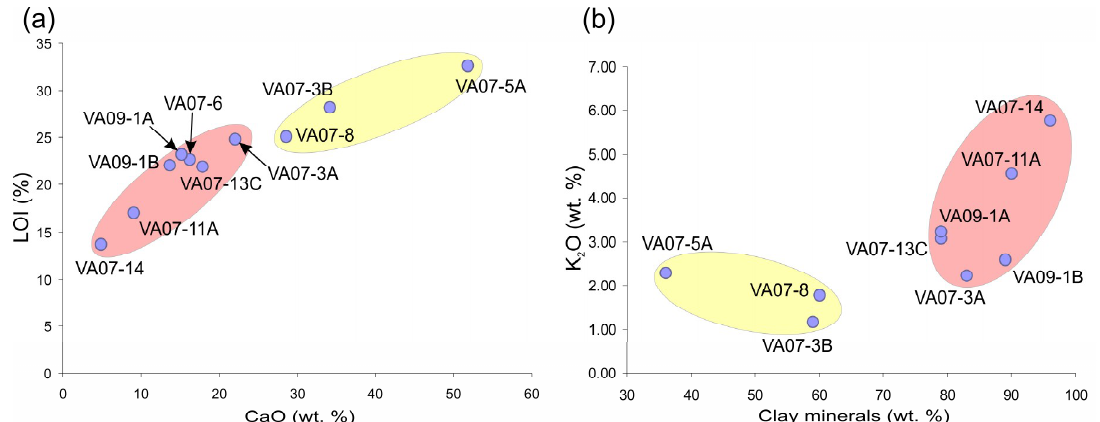
Figure 10. ( a ) LOI vs. CaO diagram of the clay samples from Vajont. ( b ) Diagram showing the relationship between the content of clay minerals from XRPD analyses and K 2 O content from XRF analyses of the Vajont clays. Two groups of different clay materials are highlighted.